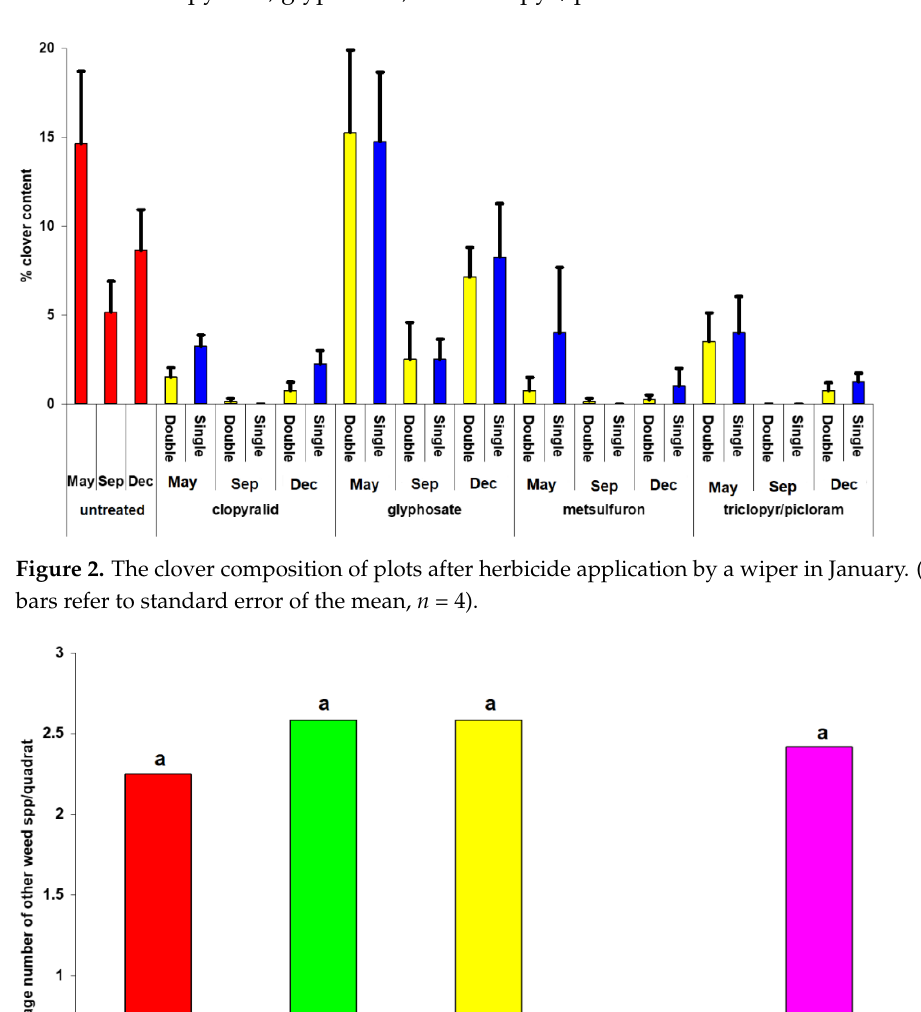
Figure 4. The number of C. arvense stems/m 2 after wiper application of herbicides at different stages. Bars with the same letter are not significantly different (LSD, p < 0.05). Analysis of clover content showed that the content of clover in both metsulfuron treatments and glyphosate late post-flowering was significantly less than that of the un- treated control (Figure 5). However, no significant differences were recorded in clover content between the untreated plot and wiper application of other herbicides. There was no visible grass injury in any of the treated plots and the composition of other weed spe- cies was also not affected by treatments (data not shown).